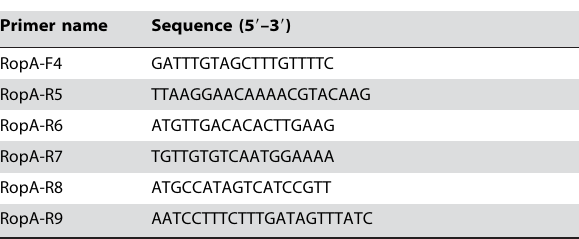
Table 1. Primers used for sequencing the ropB locus (including speB ), the covR/S locus, luxS , rofA and ropA .